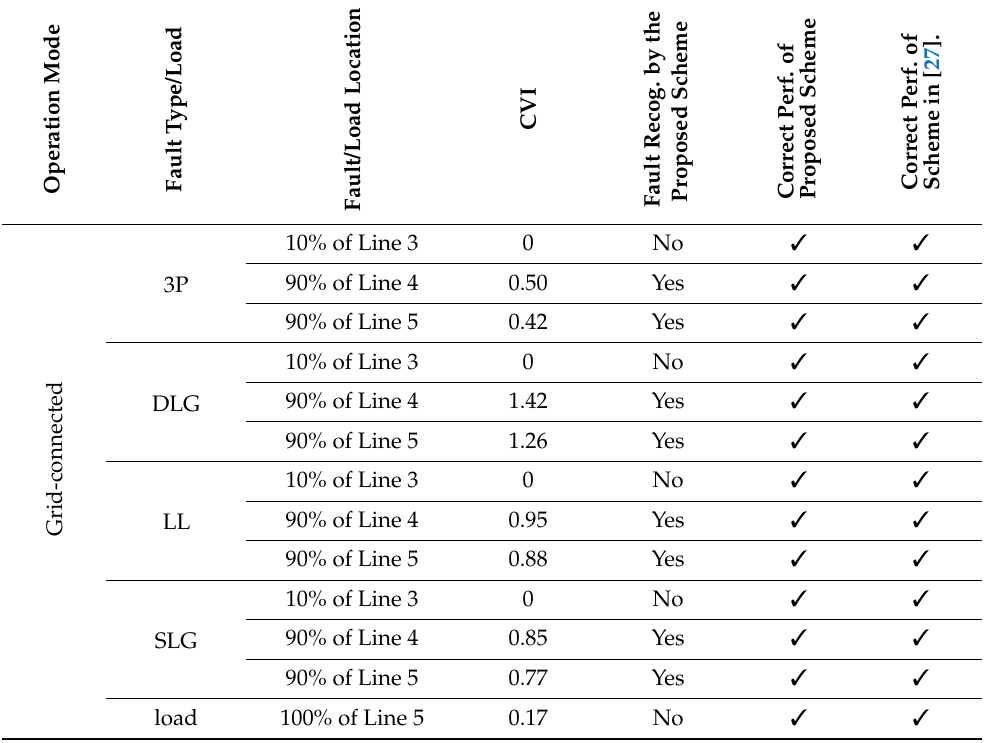
Table 9. Backup protection performance in pre-fault conditions